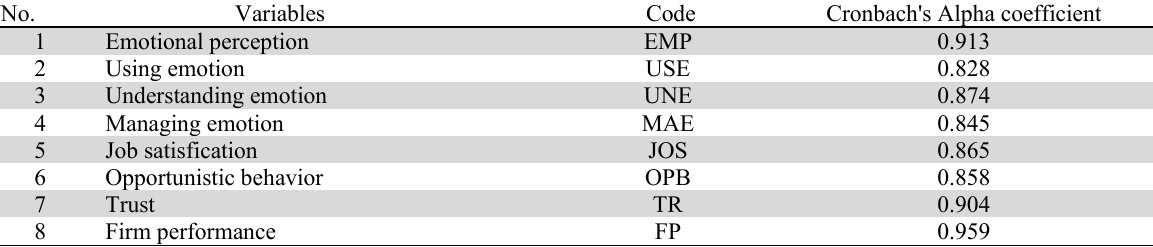
Assess the reliability of the scale through Cronbach's Alpha coefficient